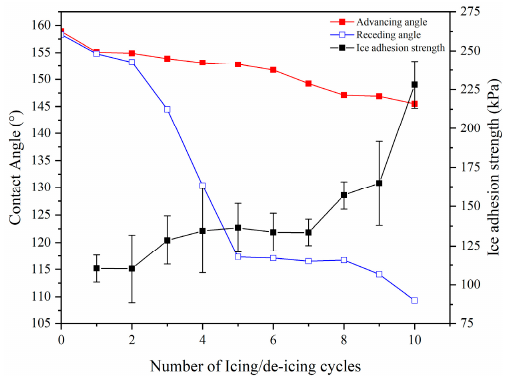
Figure 8. Ice adhesion strength and contact angles on PT5x3 for up to 10 cycles of icing/de-icing.